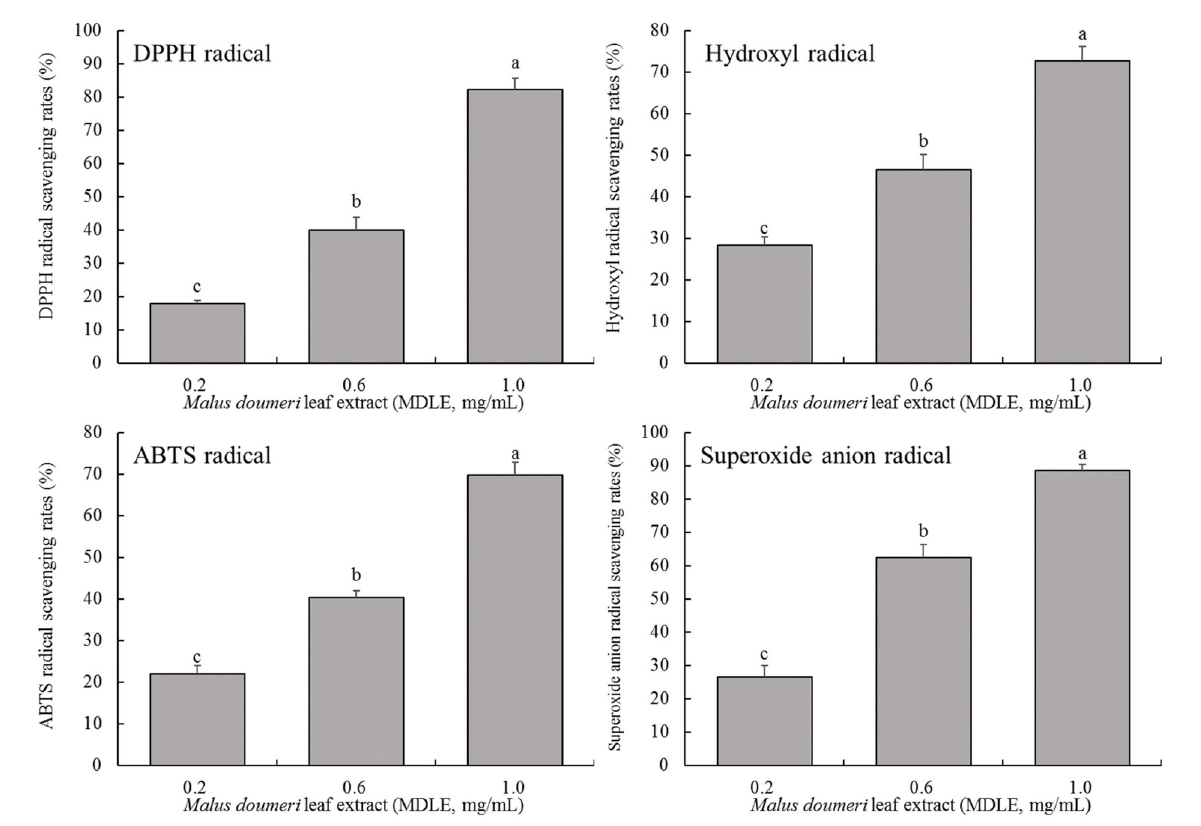
FIGURE2 Hydroxyl radical, DPPH free radical, ABTS free radical and superoxide anion free radical scavenging rates of Malus doumeri leaf extract (MDLE). a − c Lowercase letters are used to indicate significant differences at the P < 0.05 level. The same letter group indicates no difference, and the letter difference group indicates